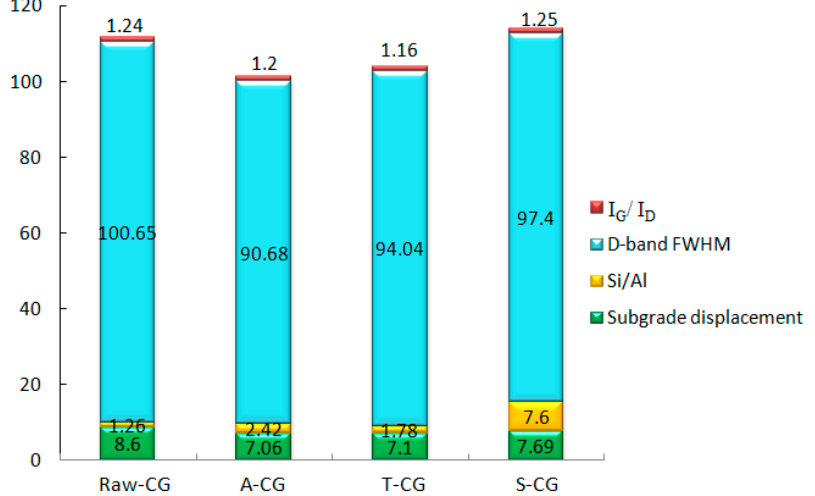
Figure 11. Comparison of final displacement and micro-influence factors.